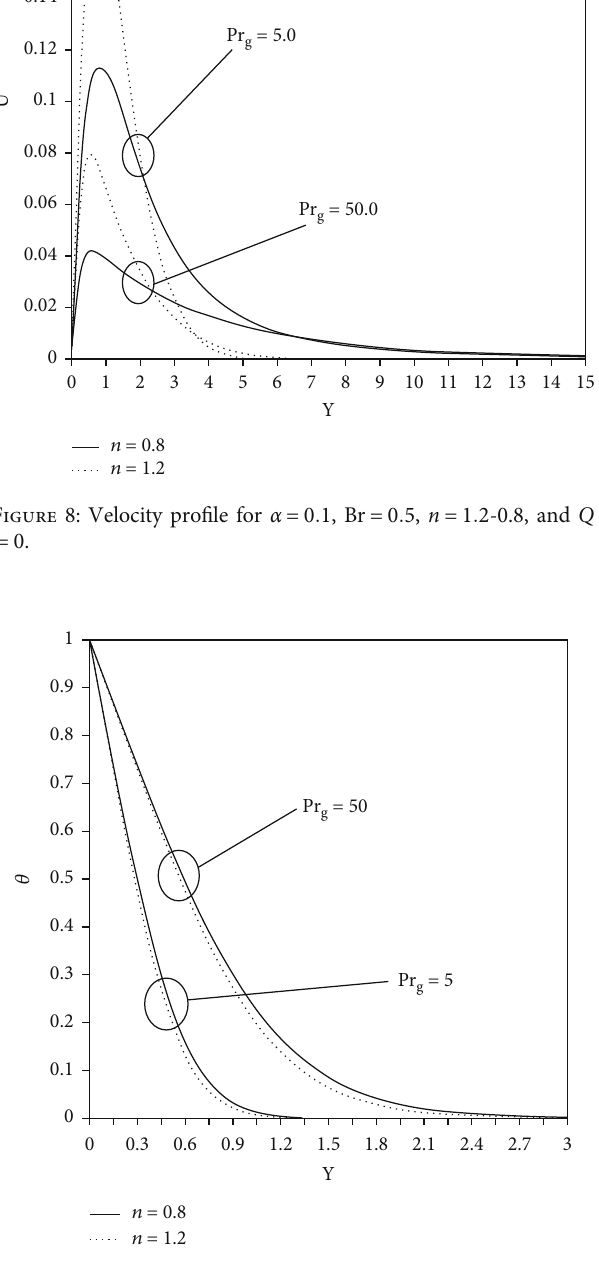
Figure 9: Thermal pro fi le for α = 0 : 1 , Br = 0 : 5 , n = 1 : 2 -0.8, and Q = 0 .